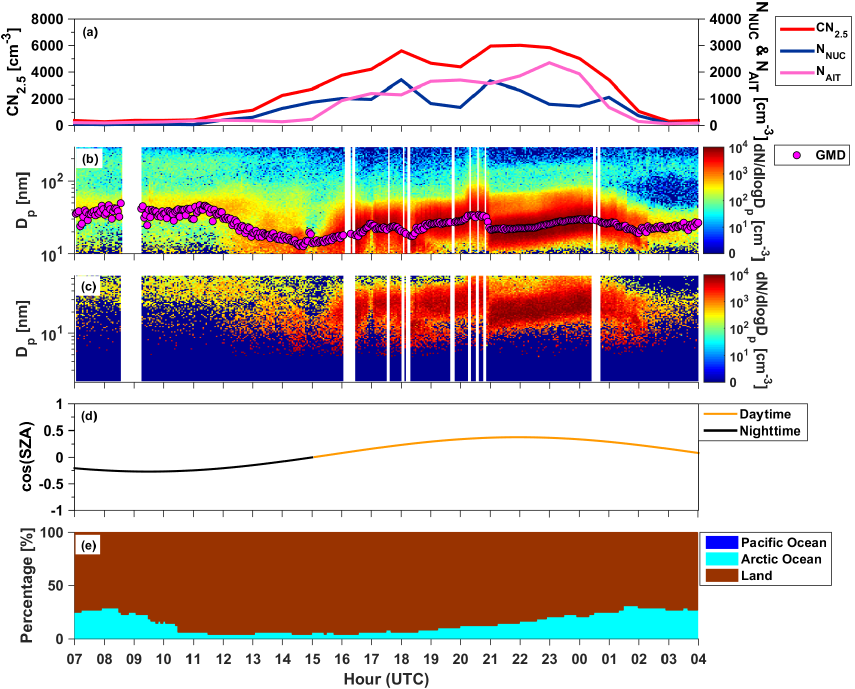
Figure 5. Example of a case II event that was observed on 13–14 September 2017. From top to bottom, the parameters are as follows: (a) the total number concentration of particles smaller than 2.5nm, nucleation-mode particles and Aitken-mode particles; (b) a time series of the standard-SMPS size distribution and GMD; (c) a time series of the nano-SMPS size; (d) cosine values of solar zenith angle; and (e) the residence time of air masses that passed over the ocean, land and sea-ice